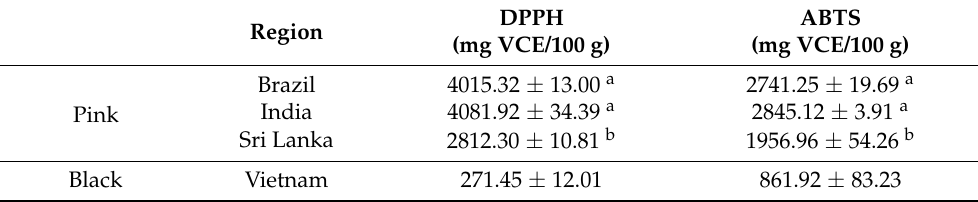
Table 3. Radical scavenging capacities of pink and black peppers.